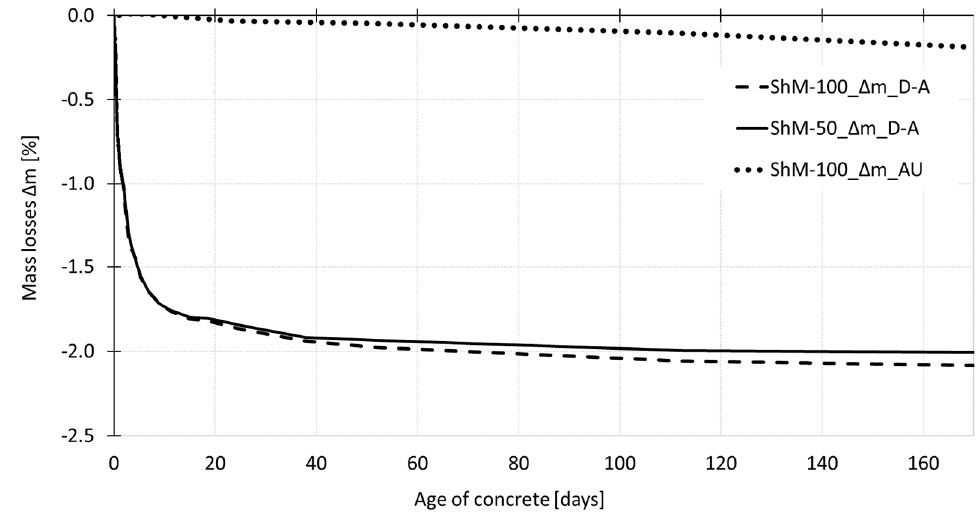
Figure 11. The overall process of mass losses ( Δ m) determined for specimens of different dimensions cured under dry air conditions.